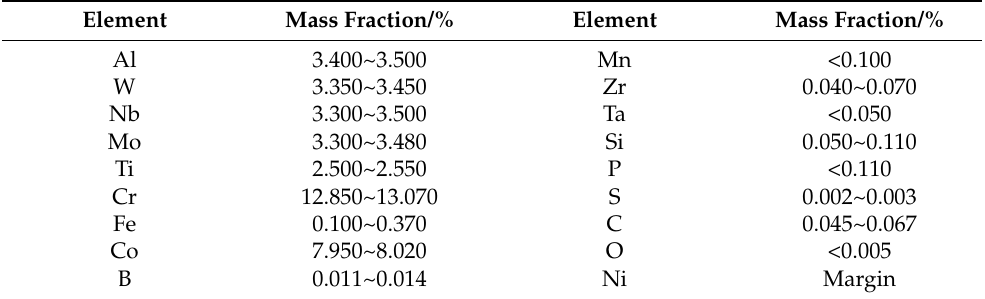
Table 1. Chemical compositions of the FGH95 superalloy.